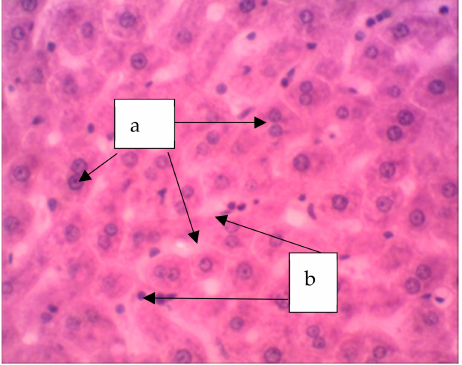
Figure 8. The liver of a rat. Increase in the volume of hepatocytes with two nuclei (a), increase in volume of Kupffer cells (b). Staining with hematoxylin–eosin, × 400.